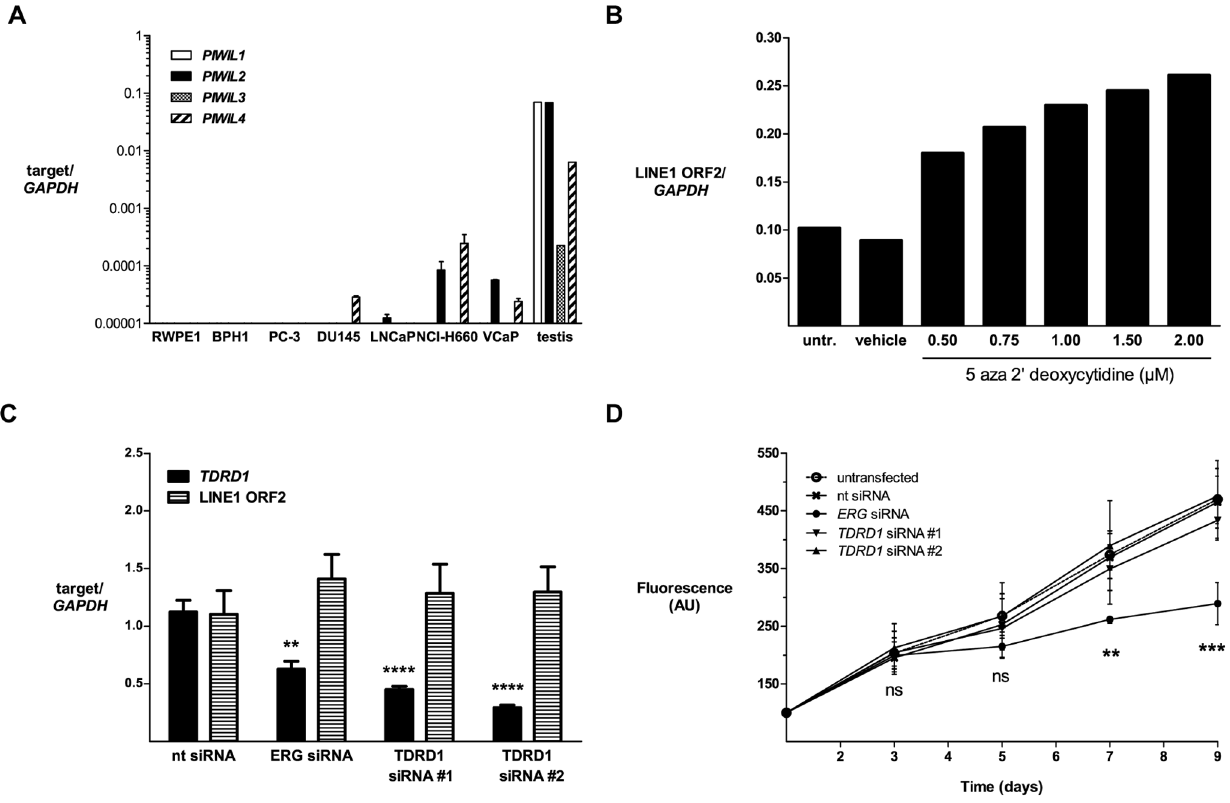
Figure 5. TDRD1 does not control LINE1 activity in TMPRSS2:ERG -positive VCaP cells. (A) mRNA expression analysis of PIWIL genes in prostate cell lines by qRT-PCR. Testis RNA was used as a positive control. (B) mRNA expression analysis of LINE1 ORF2 in VCaP cells following 5 days of treatment with 5-aza-2 9 -deoxycytidine. (C) mRNA expression analysis of LINE1 ORF2 in VCaP cells following prolonged (8 days) ERG or TDRD1 silencing. (D) Metabolic viability assay of VCaP cells treated with siRNAs. One (B), two (A) or three (C, D) independent experiments were performed in triplicate.